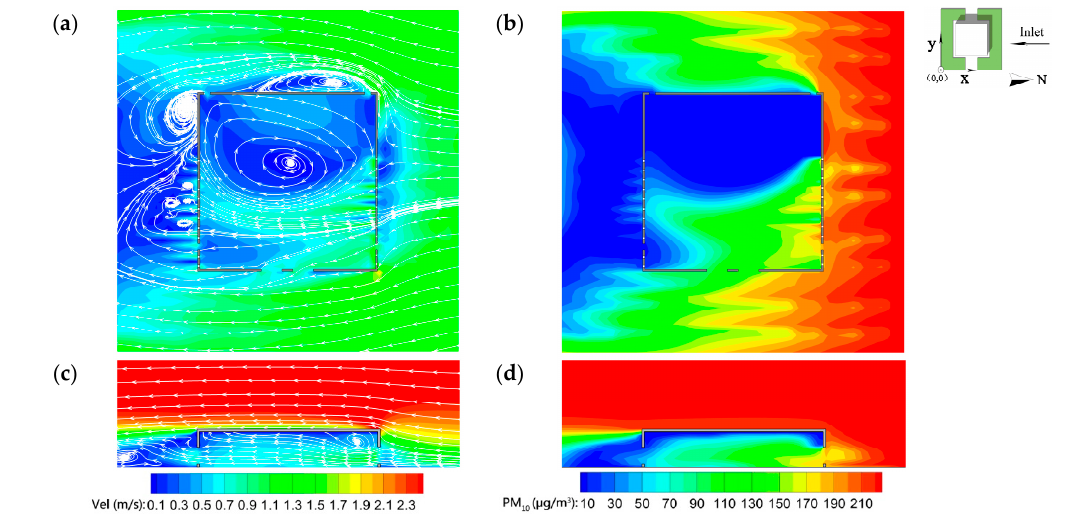
Figure 8. Airflow fields at z = 1.5 m ( a ), PM 10 distributions at z = 1.5 m ( b ), airflow fields at y = 53 m ( c ), and PM 10 distributions at y = 53 m ( d ) in the baseline scenario. Particle concentrations differ in windward areas, where the longer the distance, the lower the concentrations (Figure 9). A relatively small concentration peak appears near the windward wall of the auditorium. Because airflows converge by windows, where the particles are blocked by walls, there is a slight increase in particle concentrations. Particle concentrations inside the auditorium decrease further from the windward side. In addition, the indoor concentration is 44 to 60% of that at the inlet values due to dust retention effects of plants and windows hindering particle diffusion towards the building interior. Due to turbulent diffusion, PM 10 declines most significantly, and the deposition rate is relatively high. However, at leeward sites, concentrations are all below 50 μ g/m 3 with smaller differences, regardless of particle size. Concentrations decline faster due to the deposition effect of trees around the leeward sites.